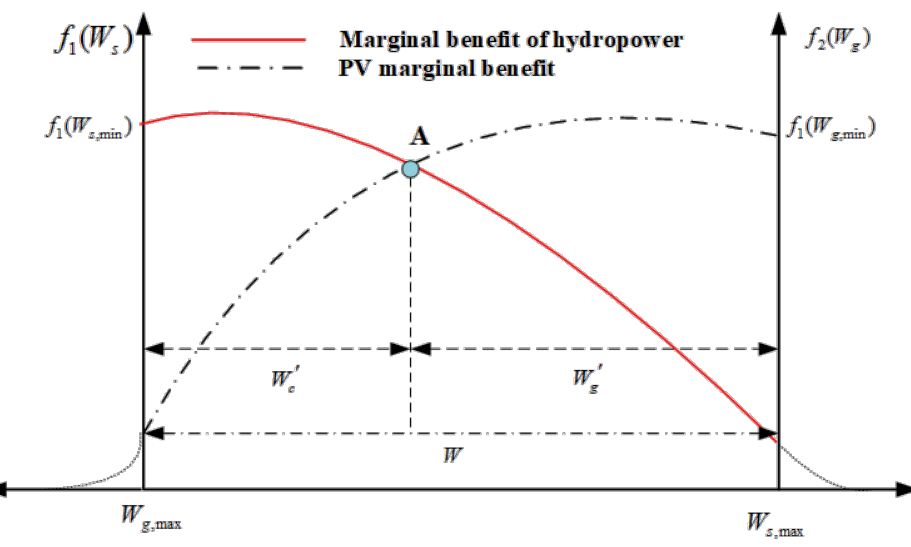
Figure 8. The best solution for hydropower photovoltaic power generation when f 1 = f 2 . According to the KKT optimal conditions of the nonlinear programming problem,